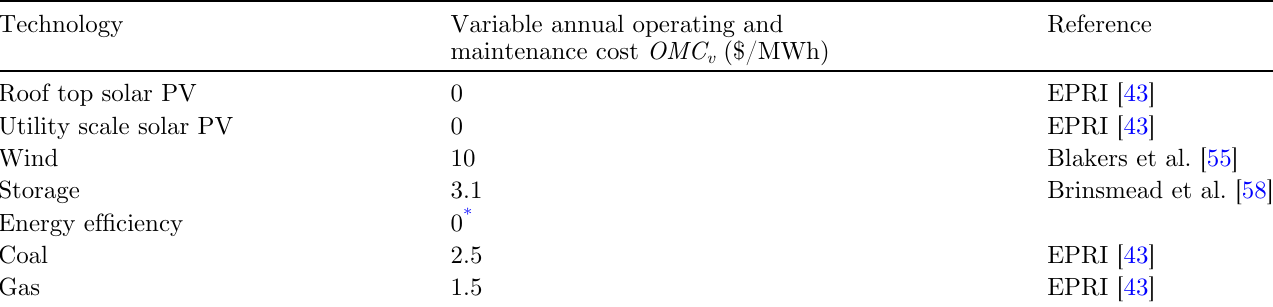
Table 9. Variable annual operating and maintenance costs for different energy generation and storage technologies.